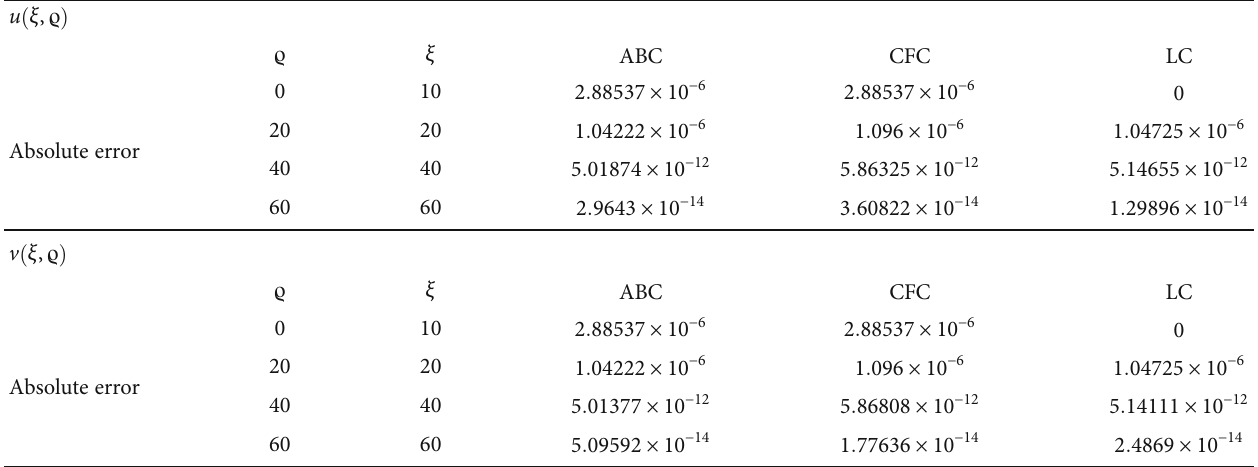
Table 6: The absolute error of u ð ξ , ρ Þ and v ð ξ , ρ Þ